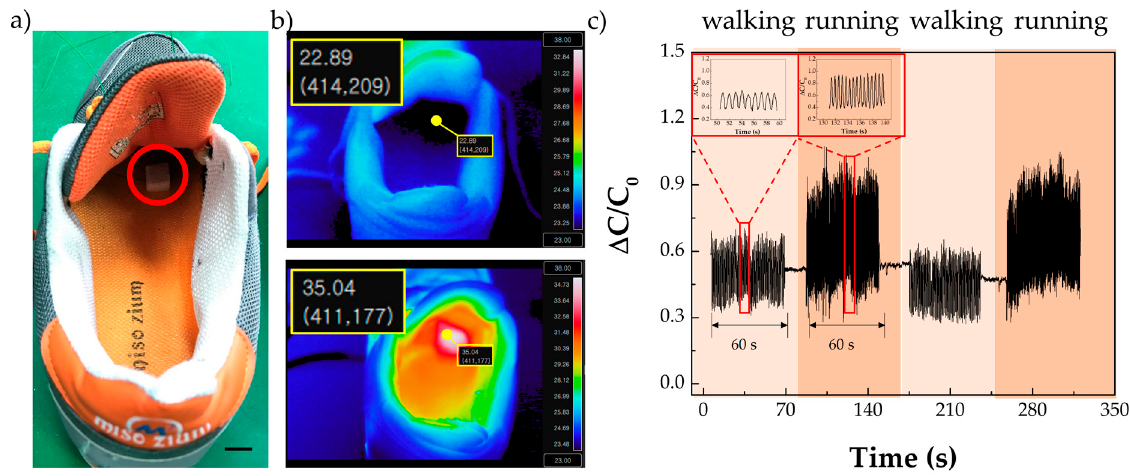
Figure 5. Application of the proposed sensor over a high pressure range; ( a ) SMP porous structure sensor on the shoe insole, scale bar = 20 mm; ( b ) Temperature in the shoe before the experiment and after the experiment; ( c ) Signal data of walking and running for 60 s.